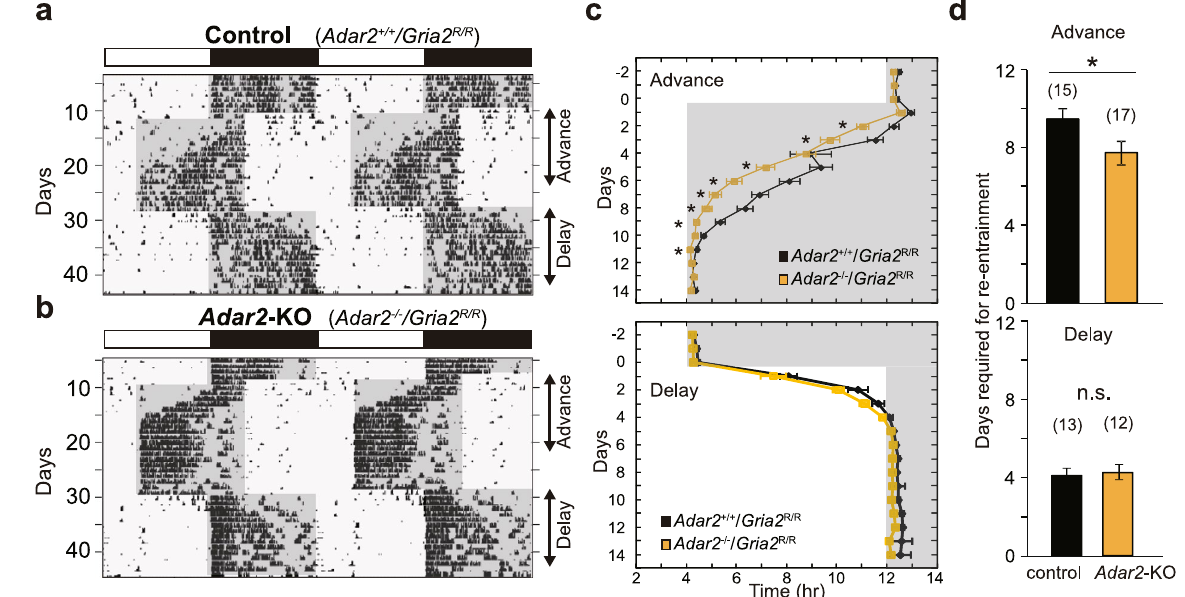
Figure 3. Re-entrainment of Adar2 -KO mouse activities to a new LD cycle. ( a , b ) Representative double-plotted actograms of wheel-running activities in the jet lag paradigm. The area with gray shading indicates the dark period. ( c ) Activity onset in the jet lag paradigm with an 8-h advance and an 8-h delay (mean ± s.e.m.; * P < 0.05 by Student’s t -test). ( d ) Days required for re-entrainment to the new LD cycles after an abrupt shift of the 12-h/12-h LD cycles with an 8-h advance and an 8-h delay (mean ± s.e.m.; n.s. P ≥ 0.05, * P < 0.05 by Student’s t -test). The numbers of animals are indicated in parentheses.